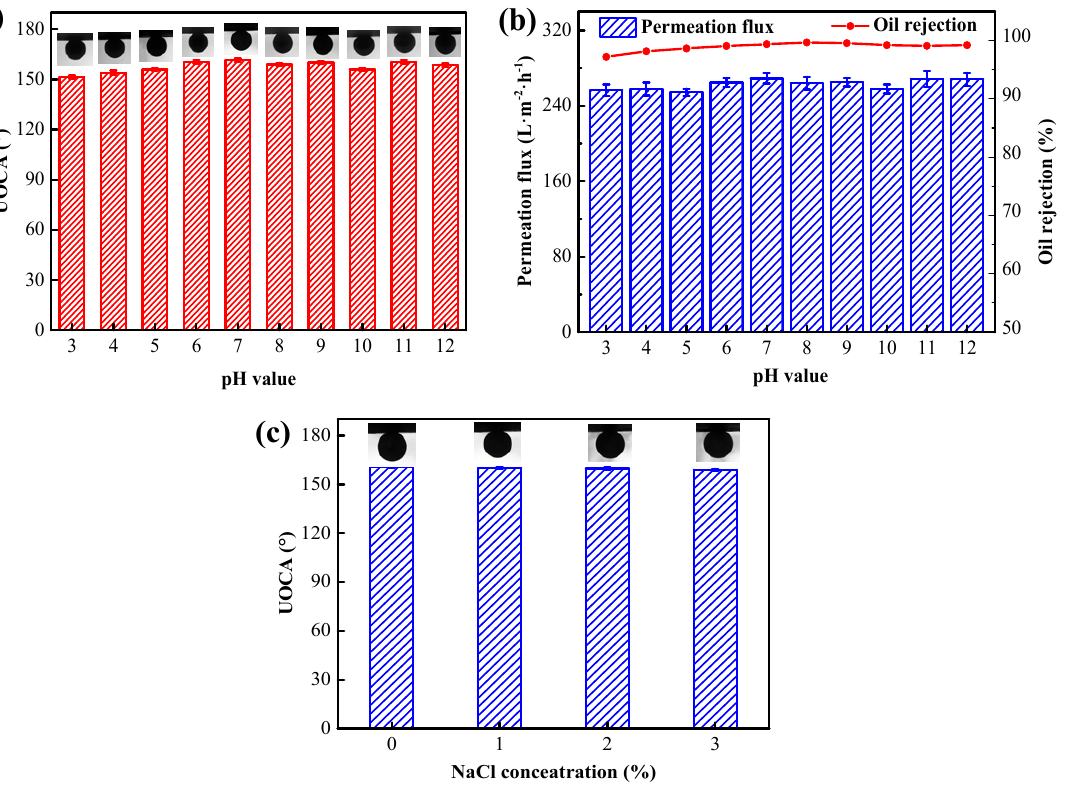
Figure 10. Stability of the F127@SMA/PVDF membrane. ( a ) UOCA after the treatment of different pH values aqueous solutions, ( b ) water permeability and oil rejection of the membrane treated by various pH values aqueous solutions for a week, and ( c ) UOCA after the treatment of different NaCl concentration solutions.